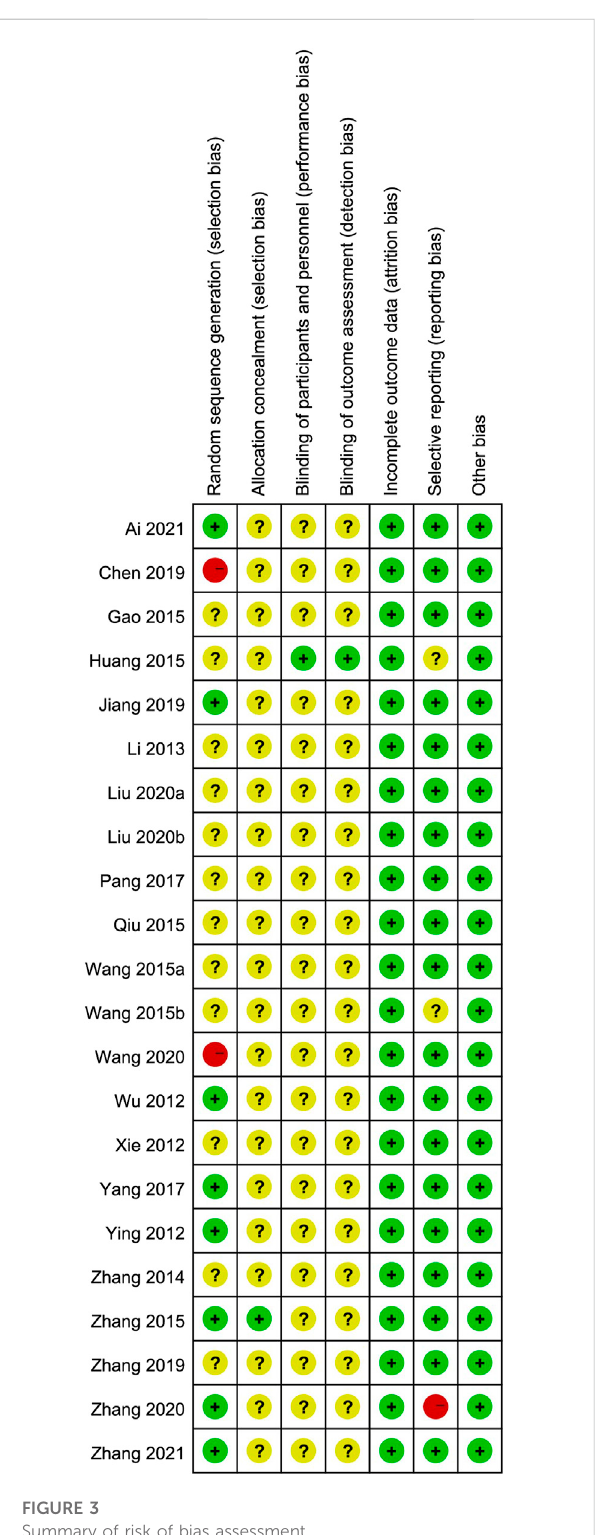
FIGURE 3 Summary of risk of bias